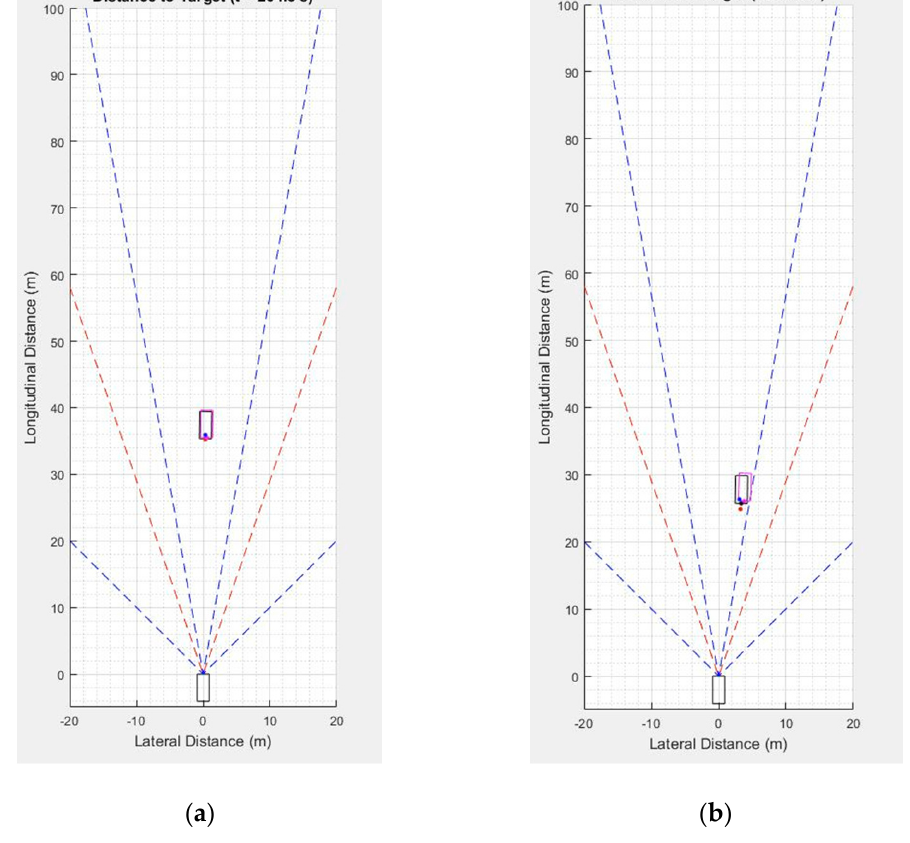
Figure 9. Normal driving scenarios considered for the localization performance evaluation of the proposed method. ( a ) Both vehicles driving in the same lane; ( b ) remote vehicle driving in the adjacent lane. Table 6. Normal driving scenario